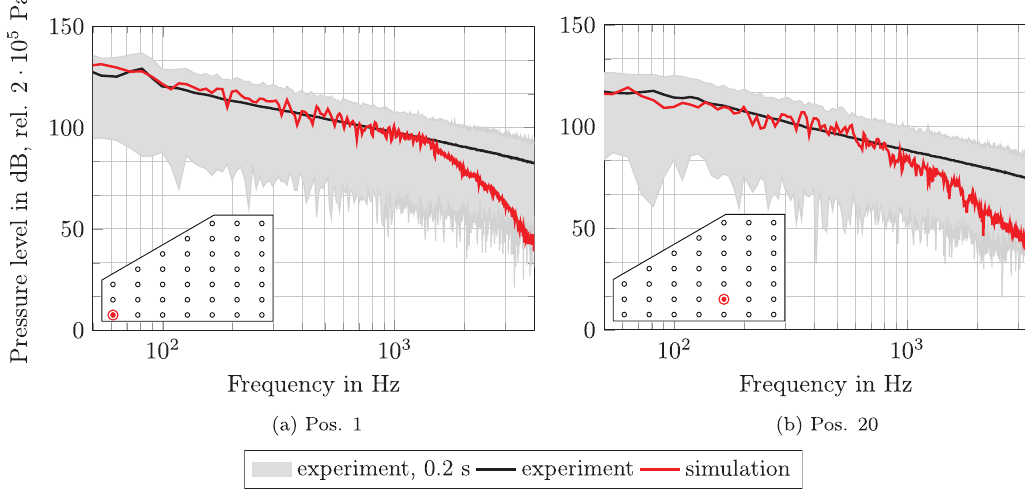
Figure 7. Frequency spectra of the wall-pressure fl uctuations in the wake of the mirror model.